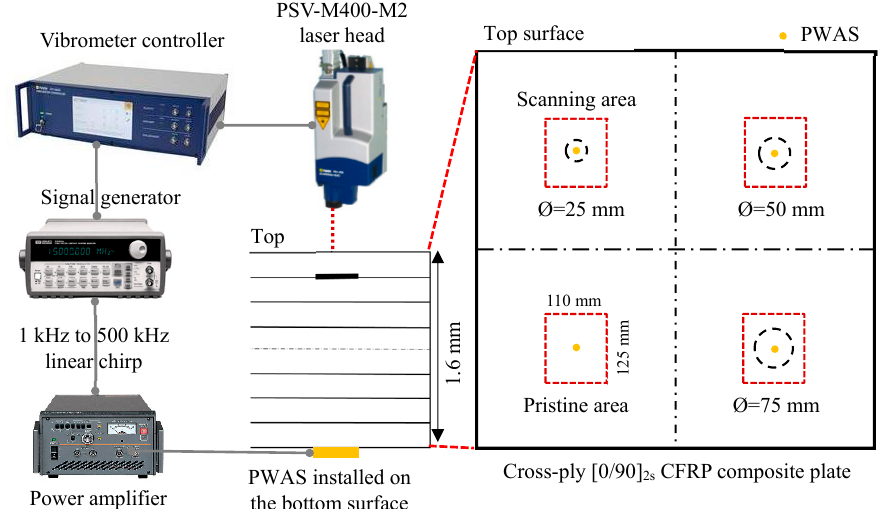
Figure 10. Experimental setup on the cross-ply [0/90] 2s CFRP composite plate using the scanning laser Sensors 2019 , 19 , x FOR PEER REVIEW